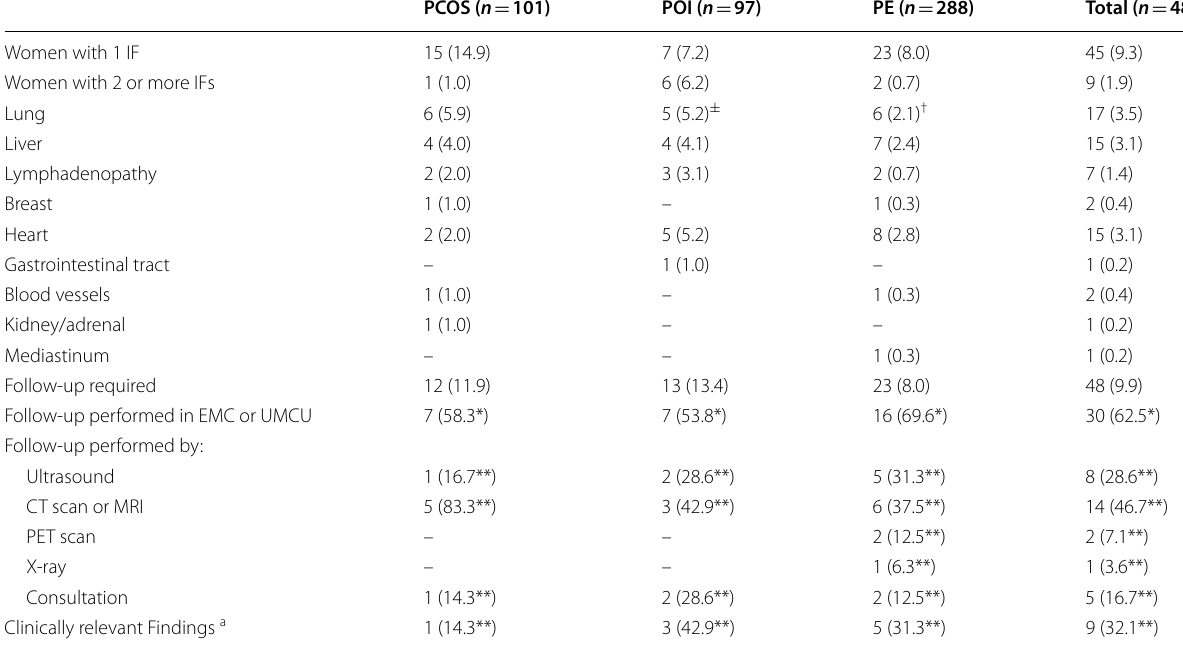
Table 2 Moderate/major incidental findings in the three different patient